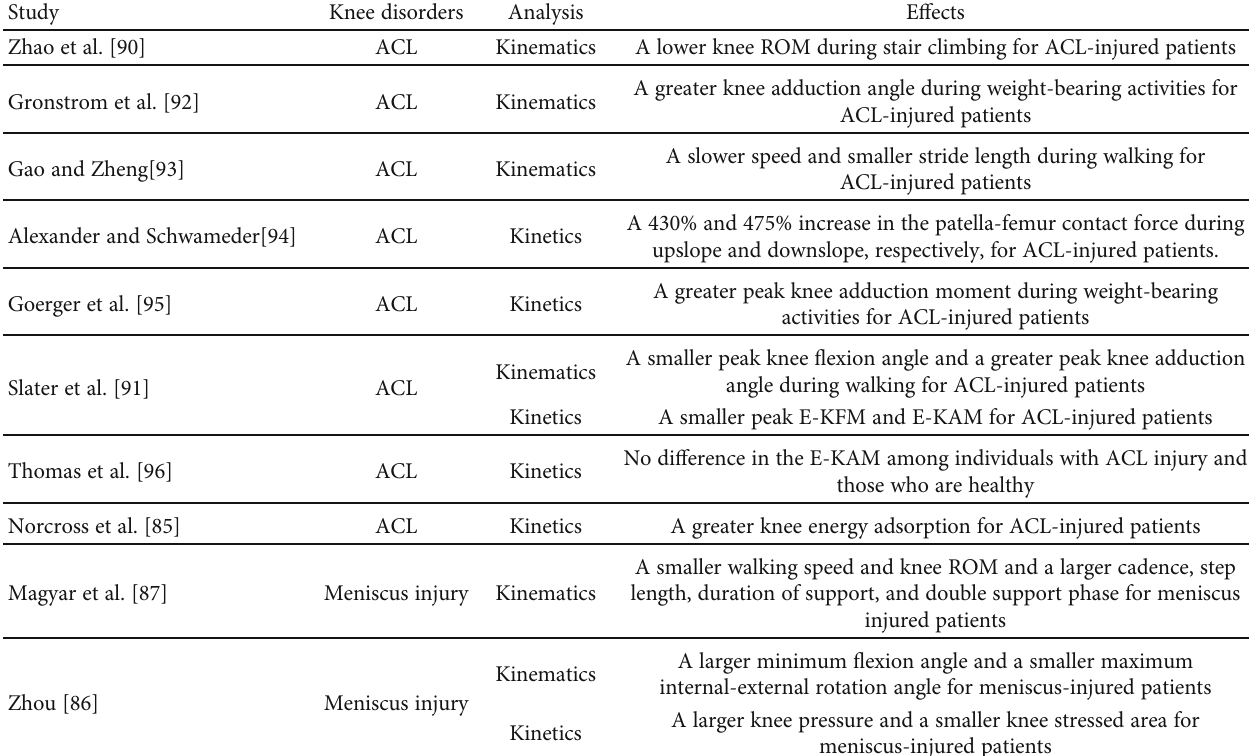
Table 13: Overview over the biomechanical e ff ects of ACL and meniscus